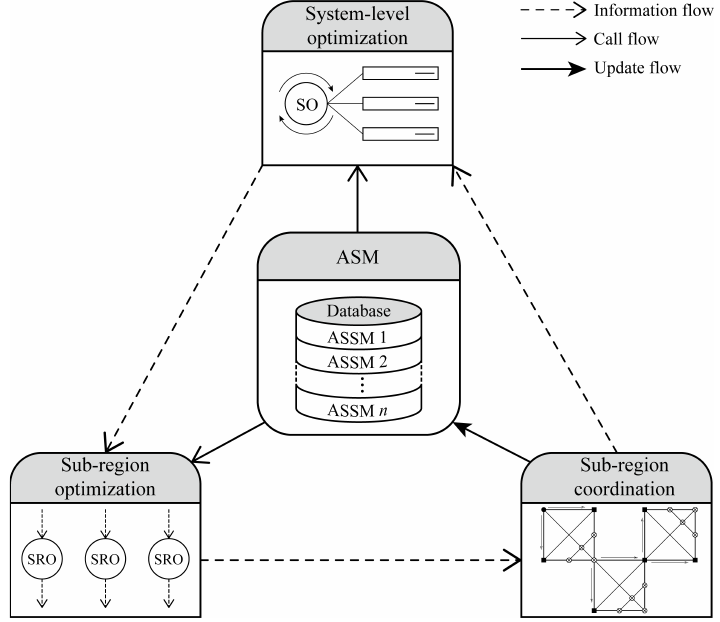
Figure 5. Interaction logic of